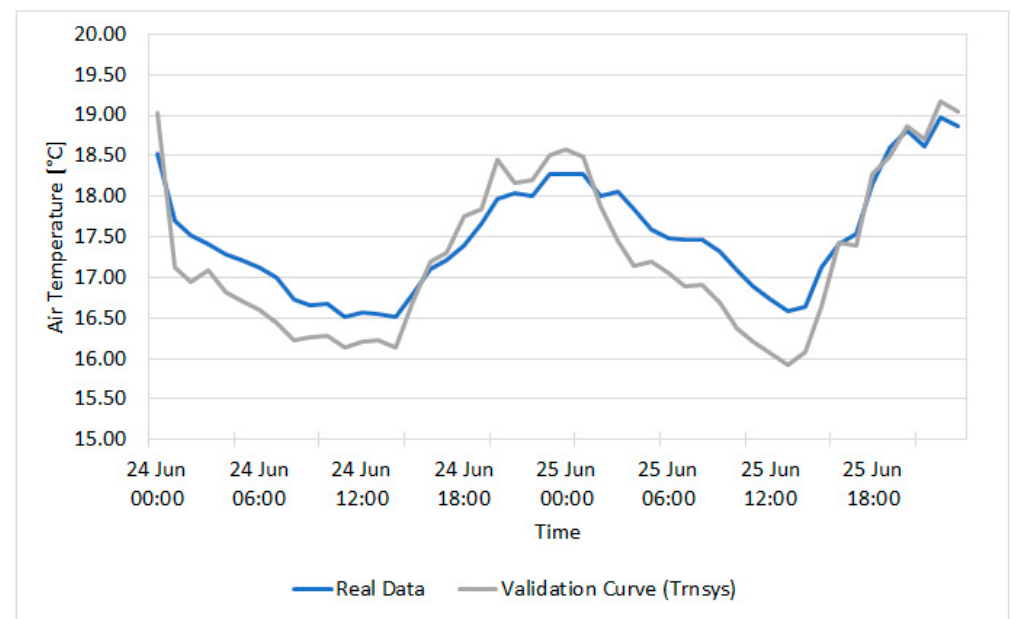
Figure 3 . Validation by comparison between experimental and numerical data (G = 450 m 3 /h). Figure 3. Validation by comparison between experimental and numerical data (G = 450 m 3